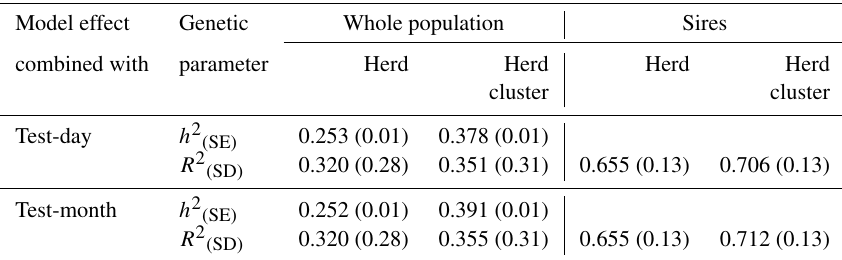
Table 4. Heritabilities ( h 2 ) with standard errors (SE) and reliabilities of estimated breeding values ( R 2 ) with standard deviations (SD) for the test-day model with herd or herd-cluster effects and for the test-month model with herd or herd-cluster effect for the whole population and for sires with daughter